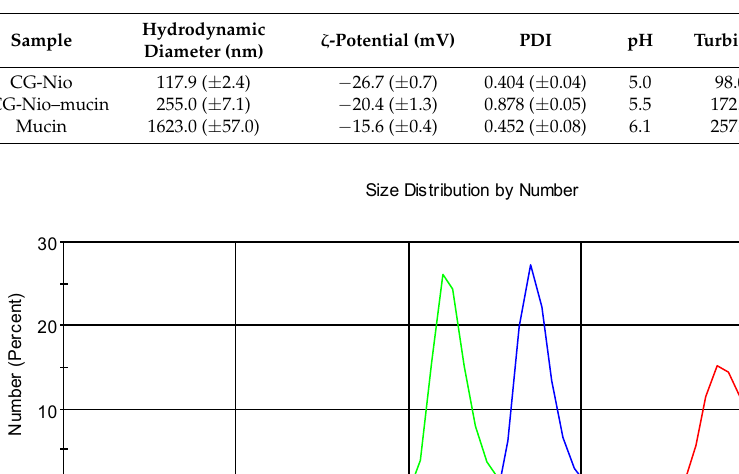
Figure 4. Particle number weighted size distribution of Nio (green), Nio–mucin mixture (blue), and mucin solution (red). Table 5. Characteristics of CG-Nio contacted with mucin dispersion.